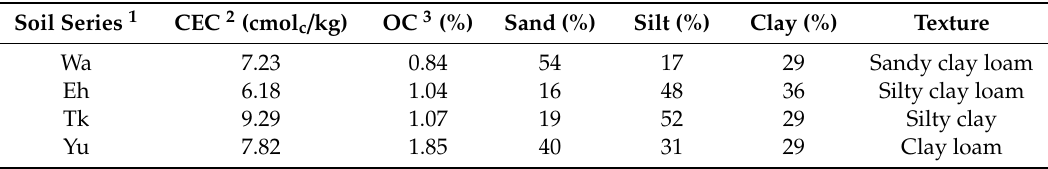
Table 1. Selected properties of the four soil